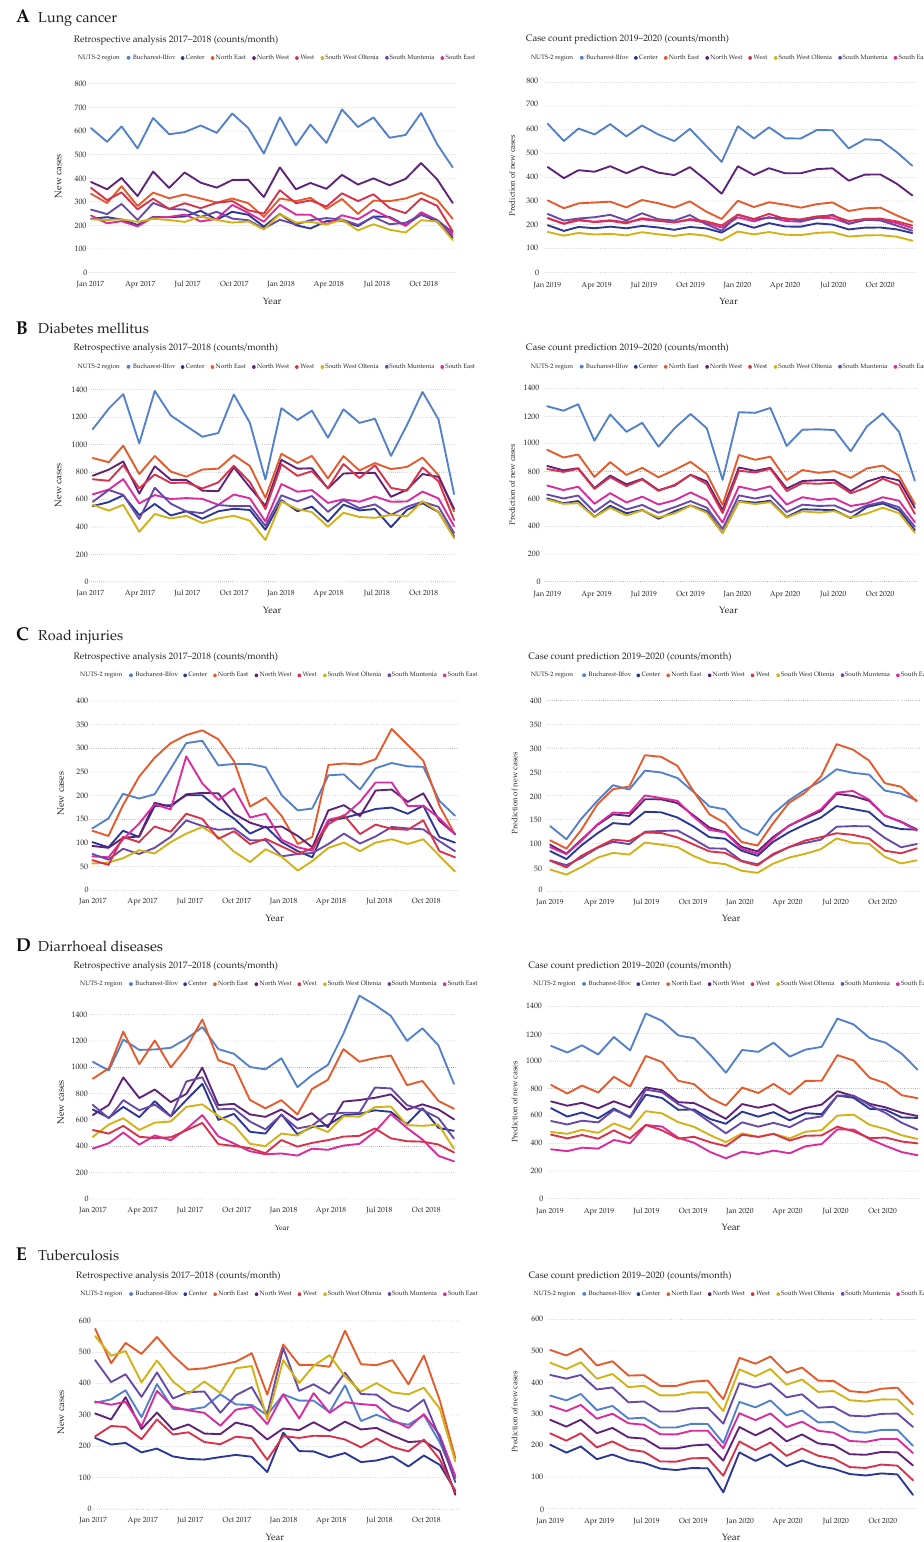
Figure 5. Comparison between total disease cases in the years 2017 and 2018 (left side) and predicted disease cases for the years 2019 and 2020 (right side). All hospitalized cases of lung cancer ( A ), diabetes mellitus ( B ), road injuries ( C ), diarrheal diseases ( D ), and tuberculosis ( E ) were plotted on a monthly basis against the predicted